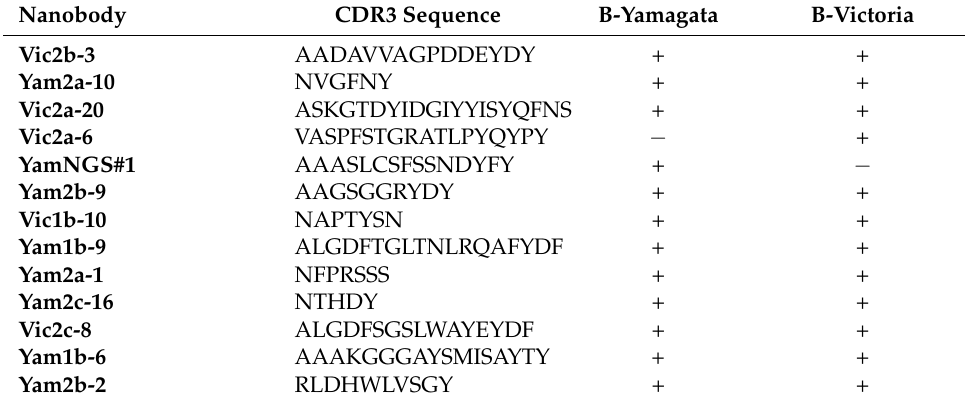
Table 1. VHH CDR3 sequences of specific single domain